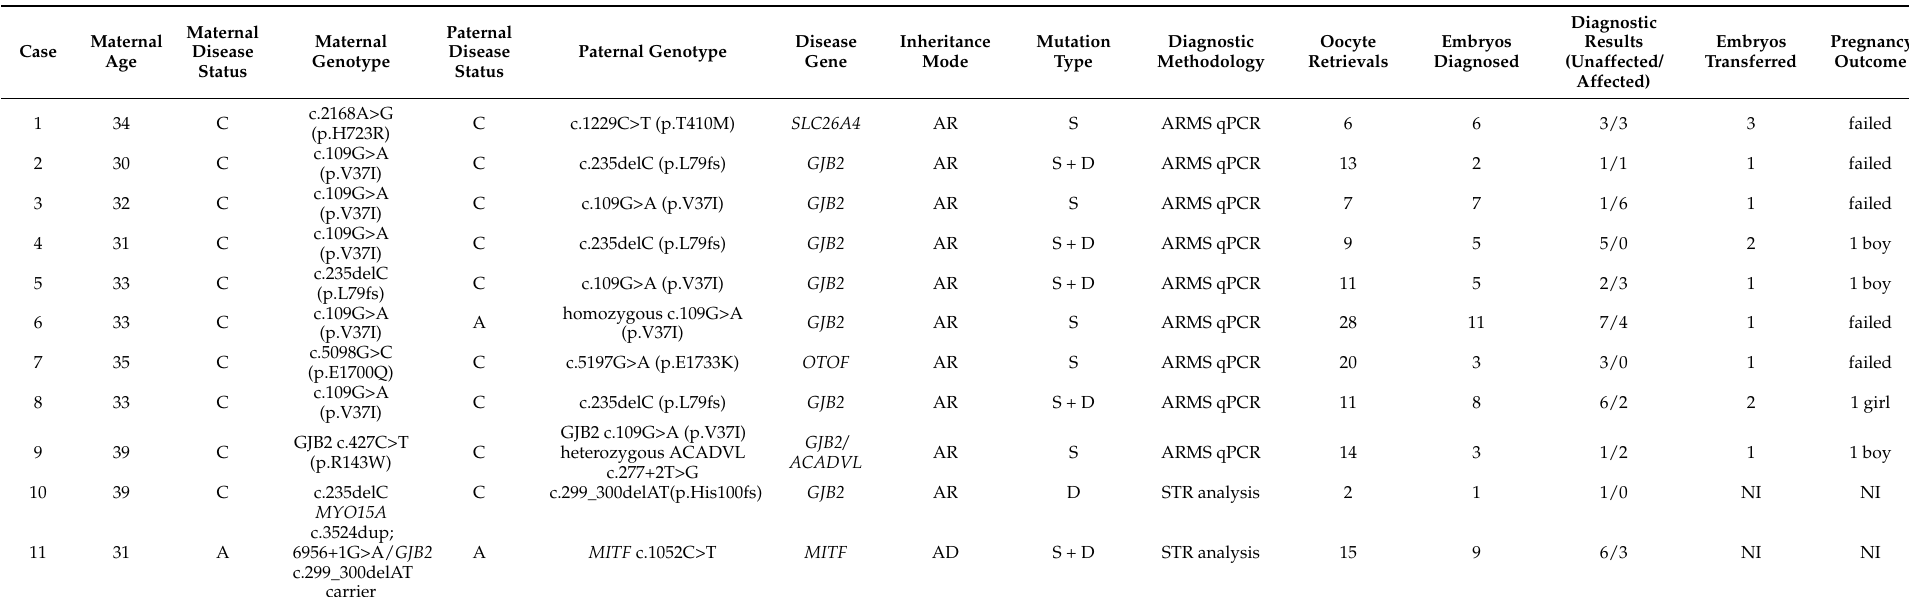
Table 1. PGD of HHI in our